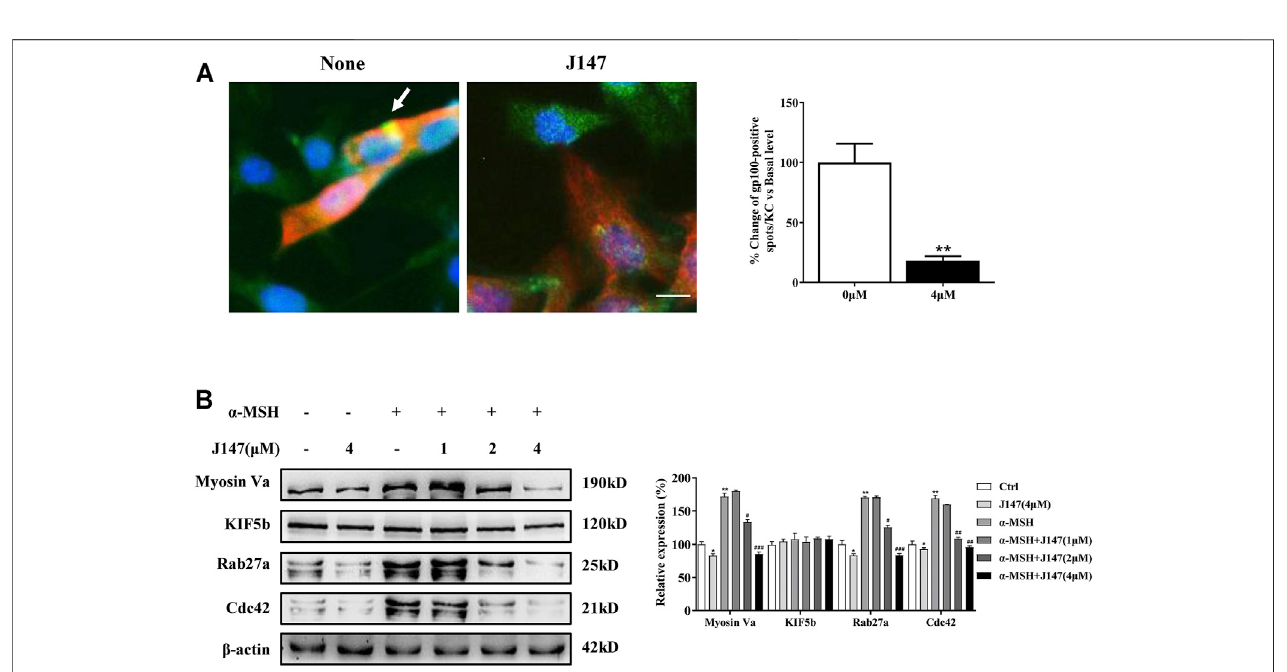
FIGURE 3 | Effect of J147 on melanosome transport in the B16F10 and HaCaT cells co-culture model. (A) In cocultured B16F10 and HaCaT cells, melanosome with yellow signal (arrow) were evident in cytokeratin-positive HaCaT cells. Melanosome labeling with GP100 (green). HaCaT cells labeling with cytokeratin (red). Bar (cid:2) 20 μ m. Quanti fi cation of melanosomes transferred to HaCaT cells. 20 cells/condition were assessed in each of three independent experiments. (B) B16F10 cells were treated with J147 in the presence or absence of α -MSH (60 nM) for 48 h and western blot was then applied to detect the Myosin Va, KIF5b, Rab27a and Cdc42 levels. Data are expressed as the mean ± SEM ( n (cid:2) 3). * p < 0.05, ** p < 0.01 vs. non-treated cells. # p < 0.05, ## p < 0.01, ### p < 0.001 vs. α -MSH-treated cells.